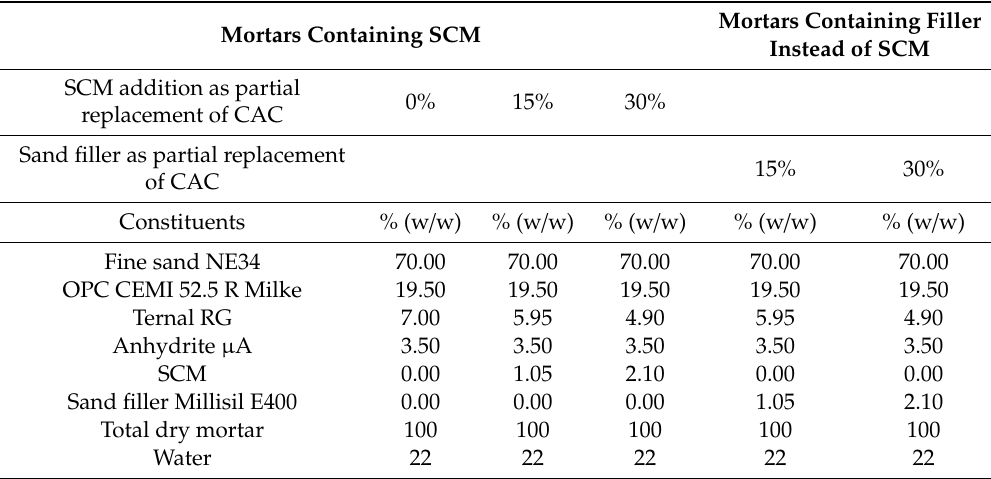
Table 1. Recipe for producing mortars, indicating the % addition of copper slag bioleach residue as supplementary cementitious material (SCM). Mortars Containing SCM